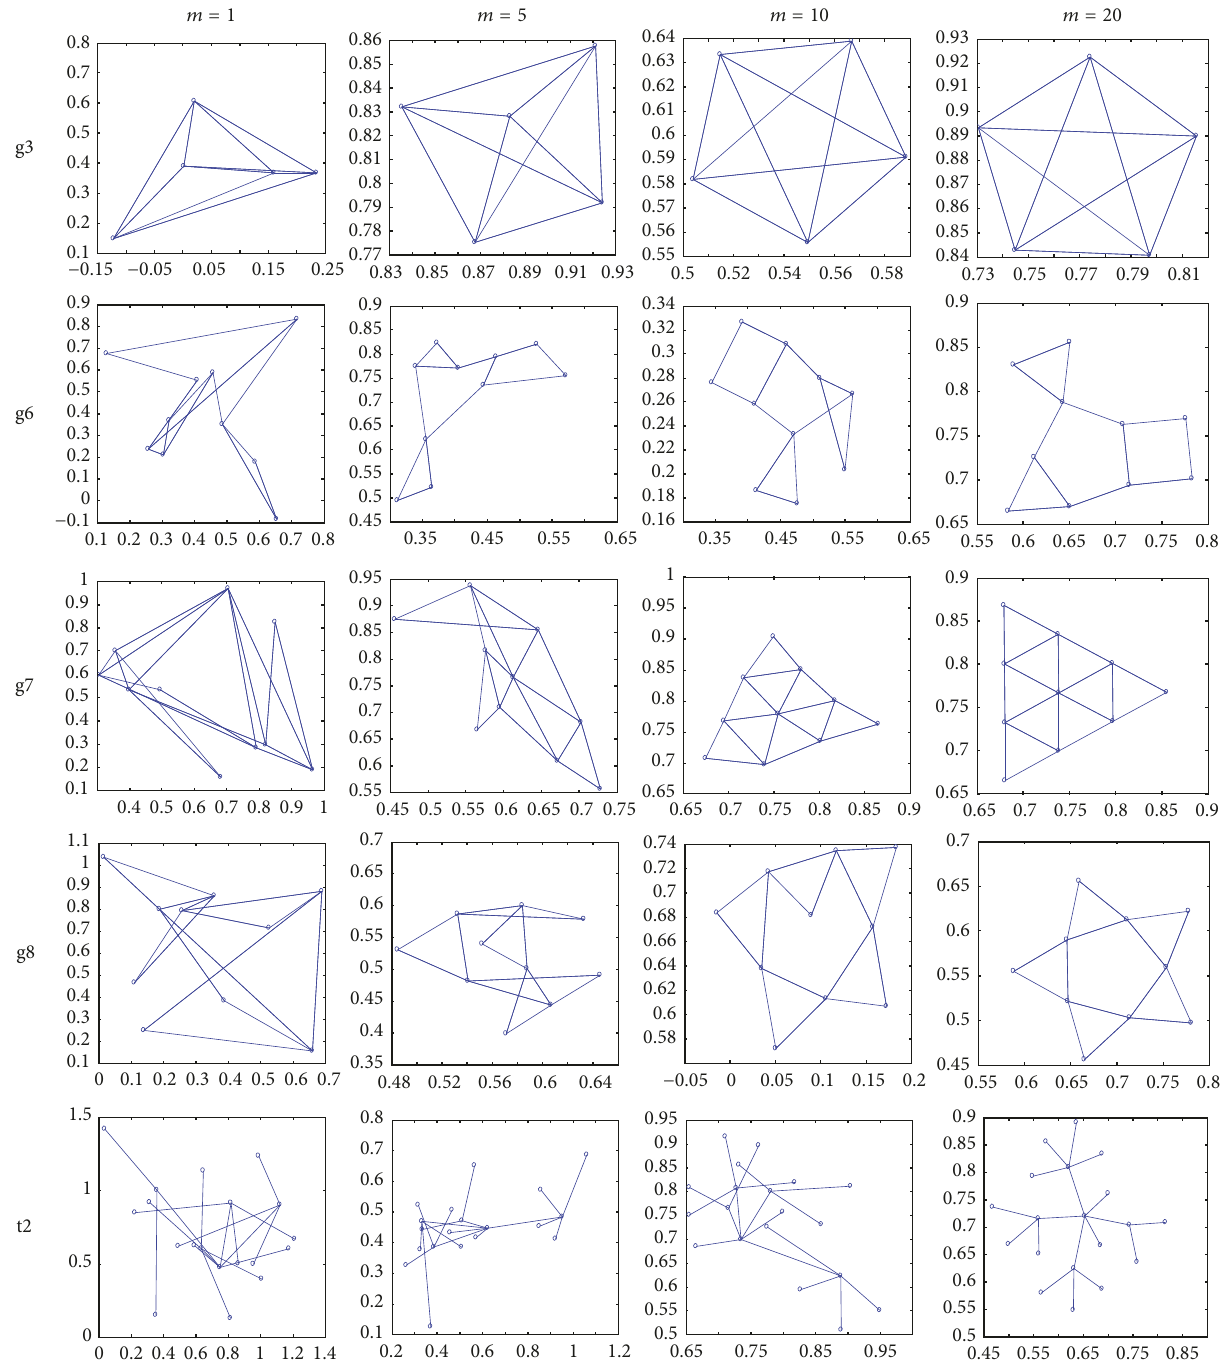
Figure 5: Evolutionary drawings with varying number of particles by